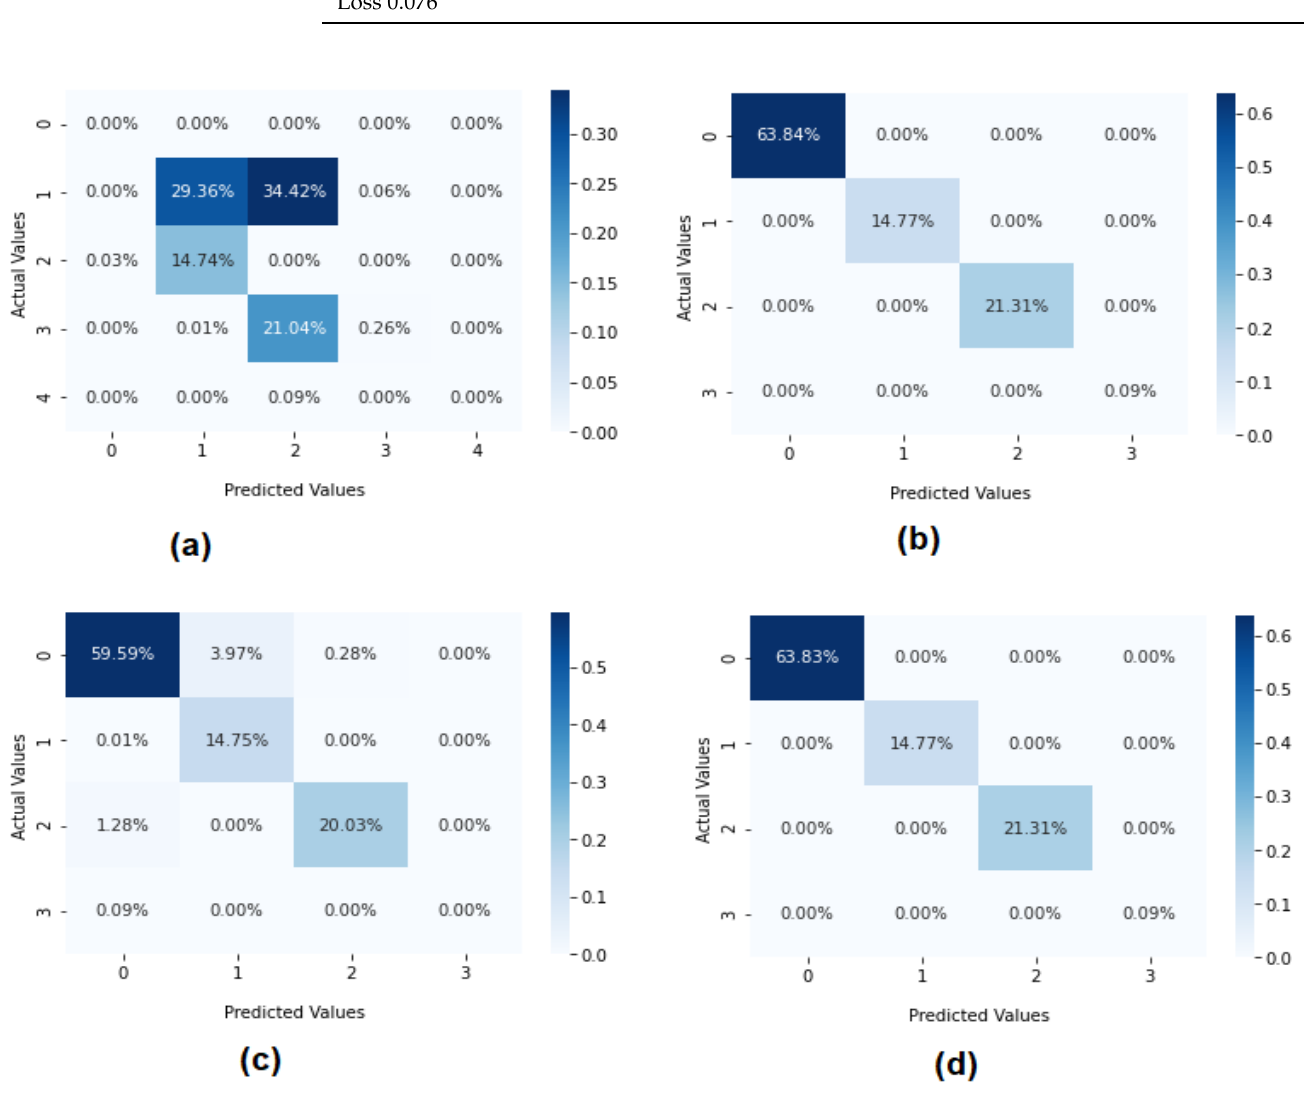
Figure 10. Confusion metrics of ML models using a multiclass classification dataset: ( a ) logistic regression; ( b ) KNN; ( c ) LDA; ( d ) DT.